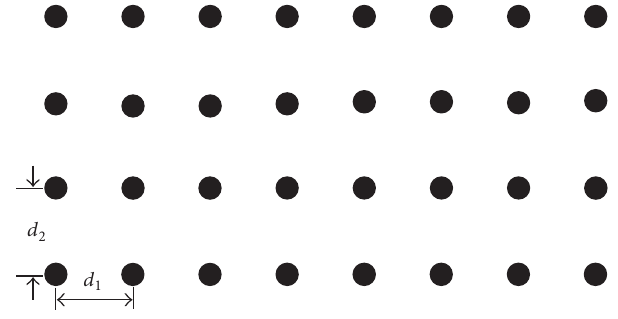
Figure 4: Receiving antenna